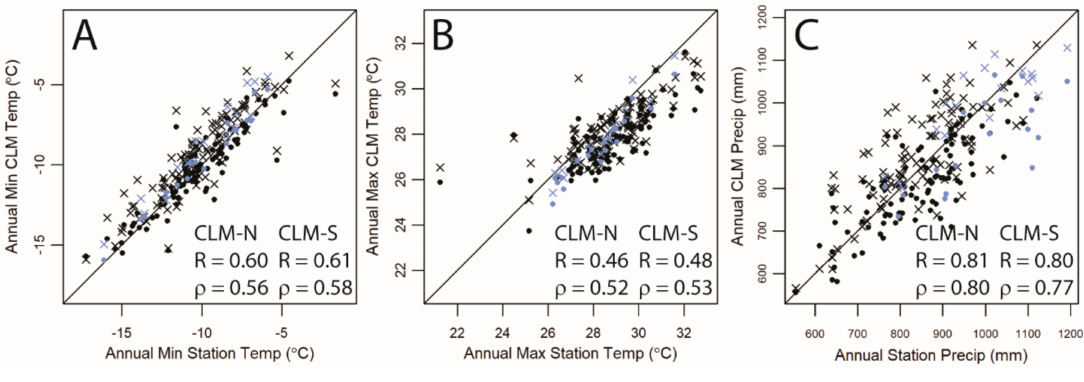
Figure 3. Scatterplots of ( A ) annual minimum of monthly average minimum temperatures; ( B ) annual maximum of monthly average maximum temperatures; and ( C ) total annual precipitation. All correlation values are significant ( p < 0.01). CLM-N are dots, CLM-S are represented by “x”. Blue dots and x identify years from 2000 to 2017. The solid line is the 1:1